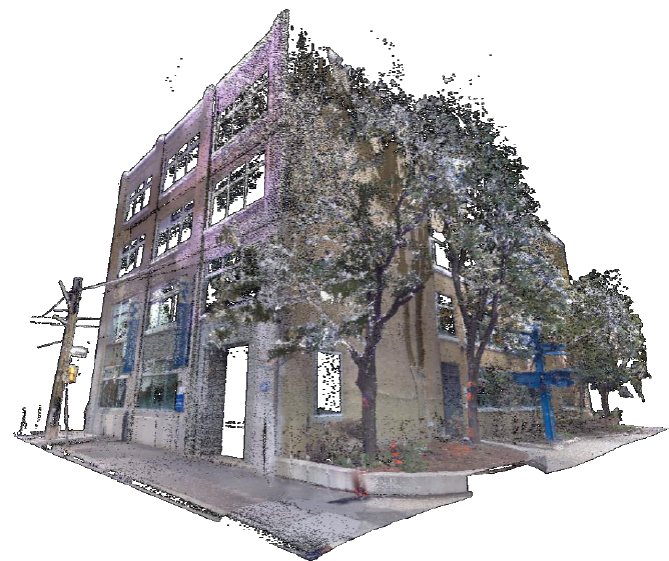
Figure 3. Scans’ locations (from 1 to 10) around the MON building ( left ) and the Polaris system scanning the building from Station #2 ( right ).